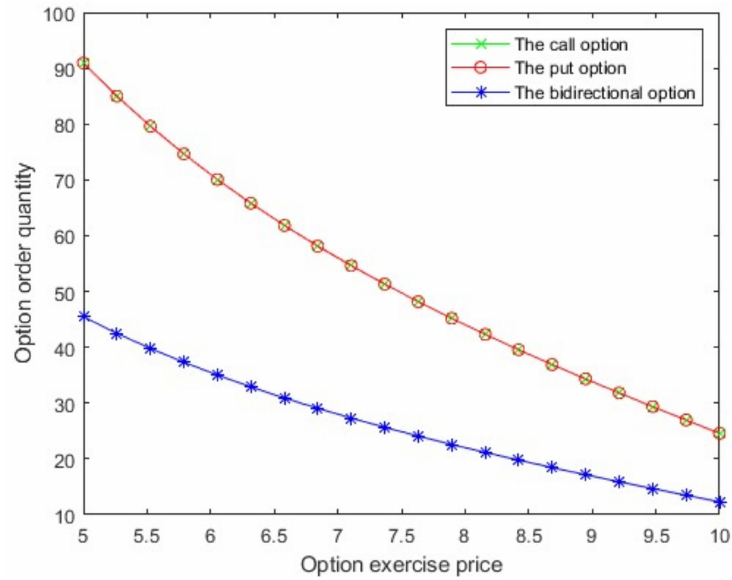
Figure 3. The option order